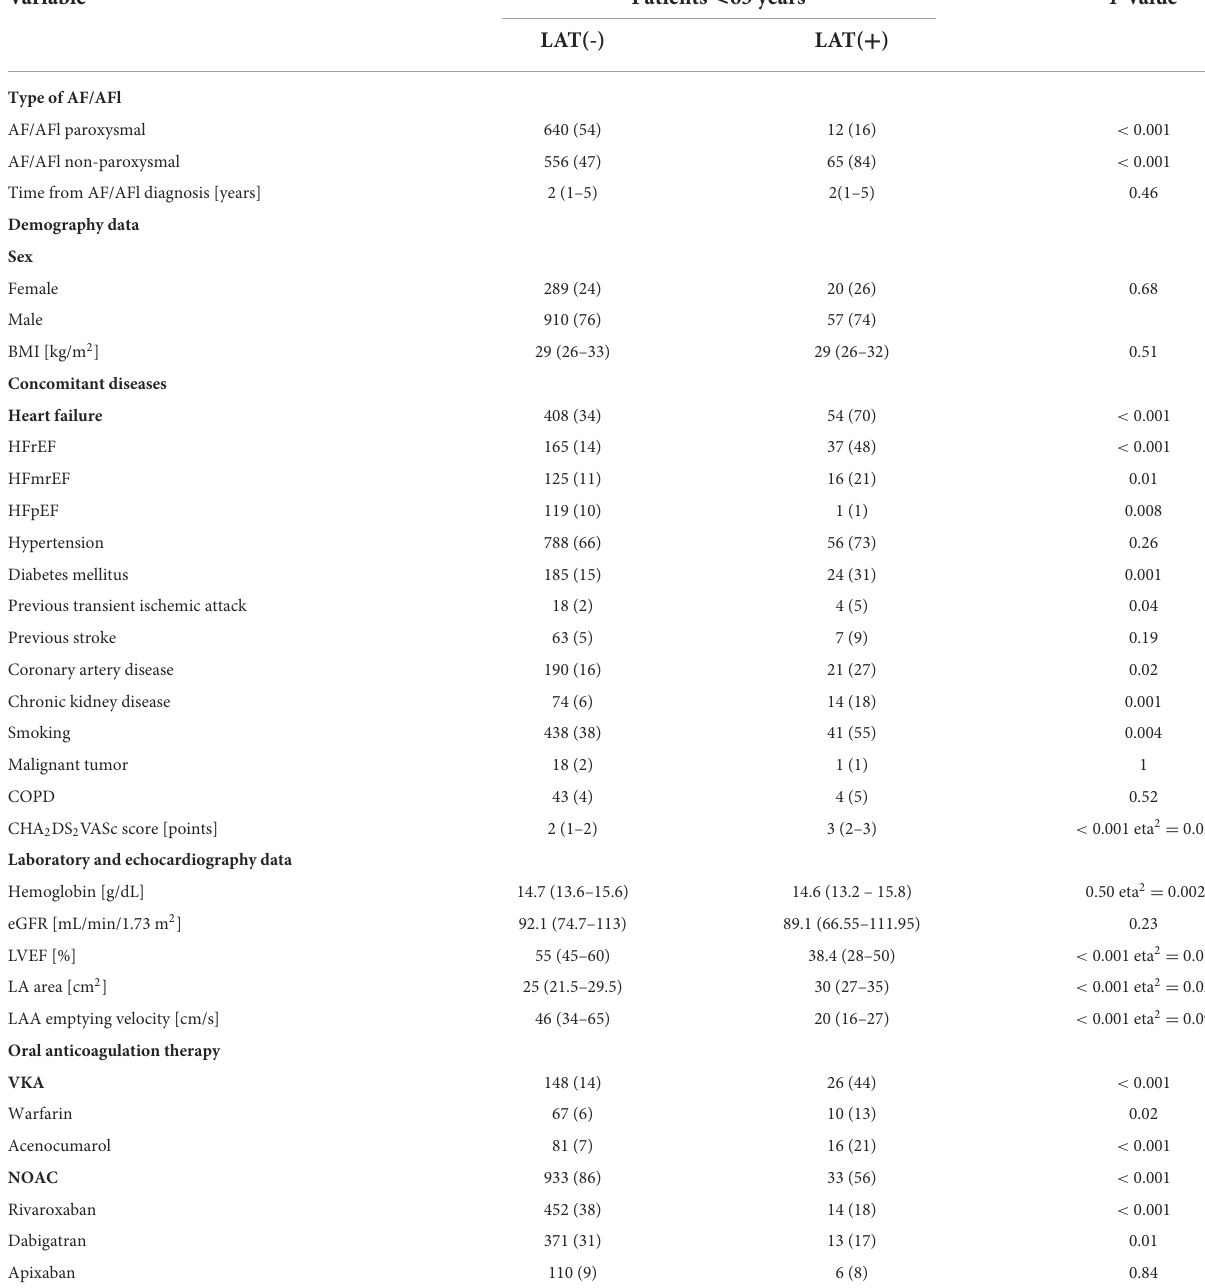
TABLE 2 Detailed characteristic of patients aged < 65 years according to the presence of a left atrial